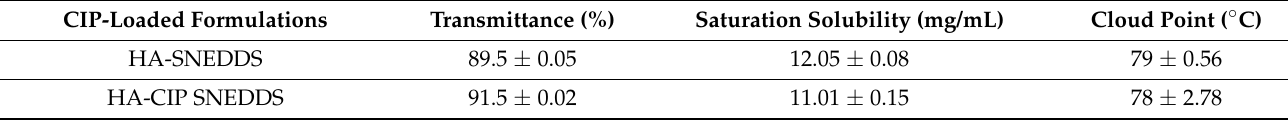
Table 2. Transmittance (%), saturation solubility, and cloud point of polymeric SNEDDS. The results are listed as mean ± S.D (n = 3).